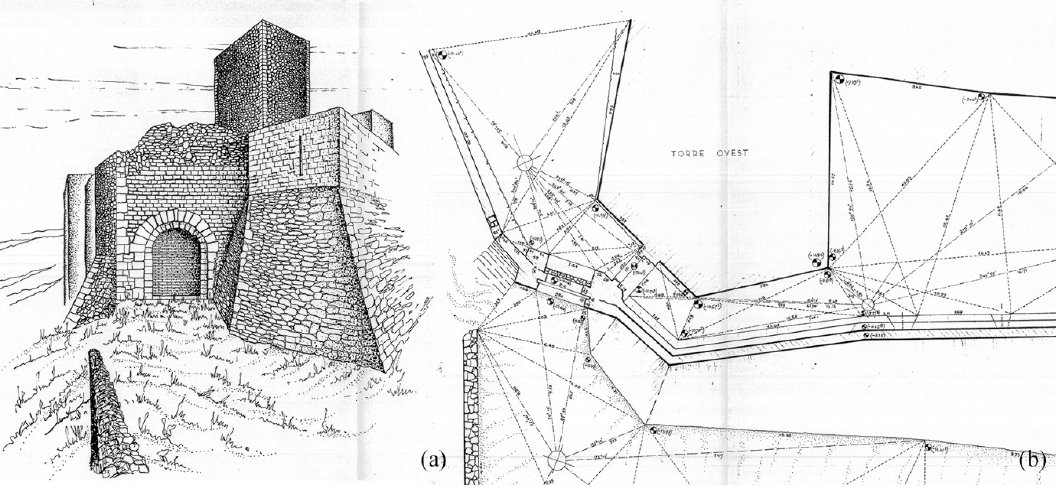
Figure 5. Perspective view ( a ) and geometrical survey ( b ) of the West Tower, elaborated at the end of the 1980s within a project of post-earthquake consolidation.